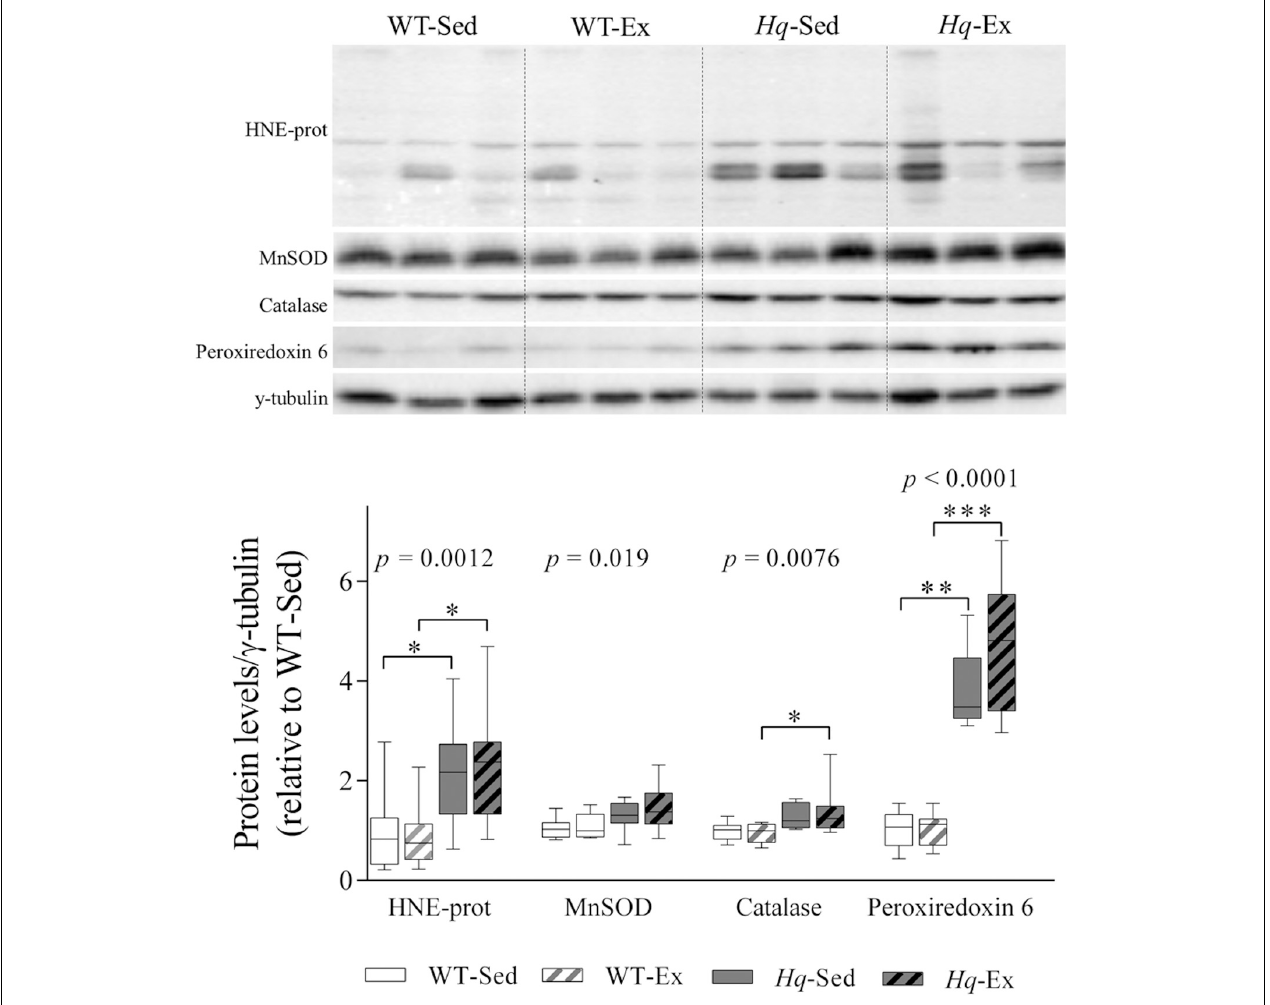
FIGURE 5 | Oxidative stress marker and antioxidant enzymes. Western blot analysis of 4-hydroxynonenal-modified proteins (HNE-prot), manganese superoxide dismutase (MnSOD), catalase and peroxiredoxin 6, in cerebellum homogenates of wild-type sedentary (WT-Sed, n = 12) and exercise-trained (WT-Ex, n = 11) mice, and of Hq sedentary ( Hq -Sed, n = 11) and exercise-trained ( Hq -Ex, n = 10) mice. Densitometry analysis: protein levels were normalized to γ -tubulin levels; data (median, interquartile range, and min and max values) are expressed relative to levels in the WT-Sed group. Significant p- values for the group effect (Kruskal-Wallis test) are shown above the corresponding boxes. Symbols for significant differences in post hoc pairwise comparisons: ∗ p < 0.05; ∗∗ p < 0.01; ∗∗∗ p < 0.001 for Hq -Sed vs. WT-Sed, and Hq -Ex vs. WT-Ex.